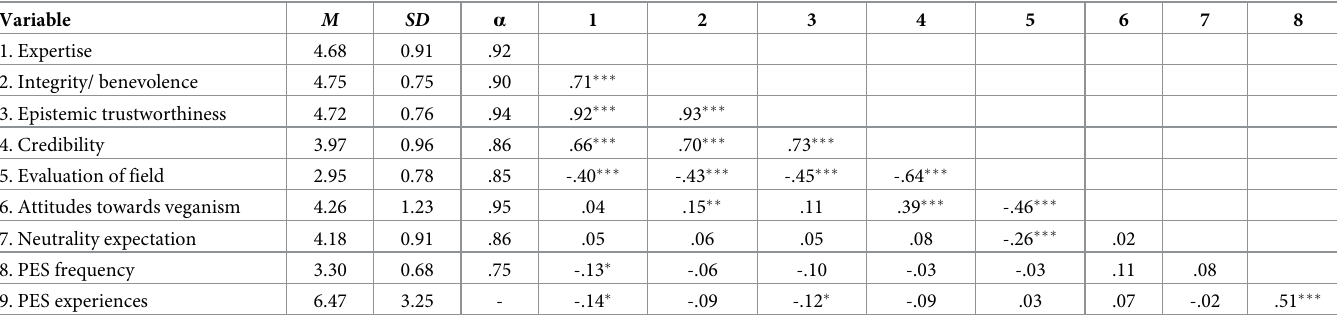
Table 3. Means, standard deviations, correlations, and internal